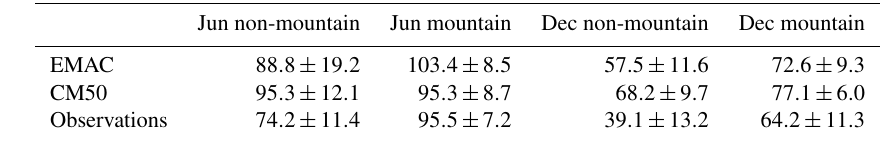
Table 4. Mean values which are subtracted from the diurnal cycle (in µgm − 3 ) for EMAC and CM50. The given uncertainty is the standard deviation over all stations.